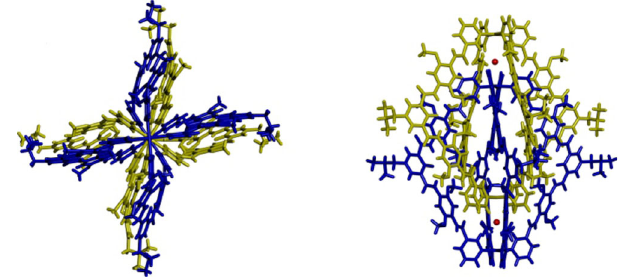
Fig. 4 Crystal structures of [2Cl ⊂ 2]. Top (left) and side (right) views of the crystal structures of [2Cl ⊂ 2 ]. Only the PPPP enantiomer is shown. The structures belong to the centrosymmetric space groups and thus also contain the MMMM enantiomer. The solvent molecules, anions outside of cavity, and disorders have been removed for